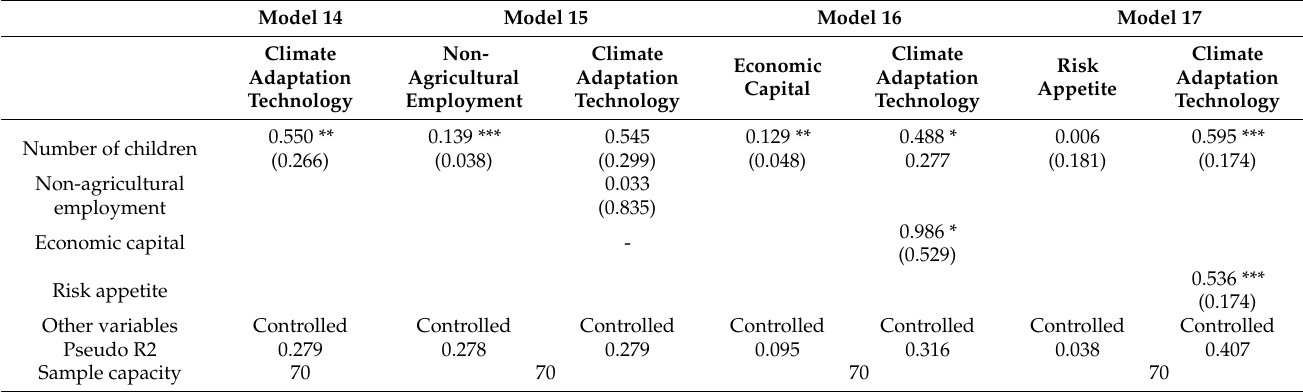
Table 8. Test of influencing factors and action mechanism of farmers’ climate adaptive technology in stable